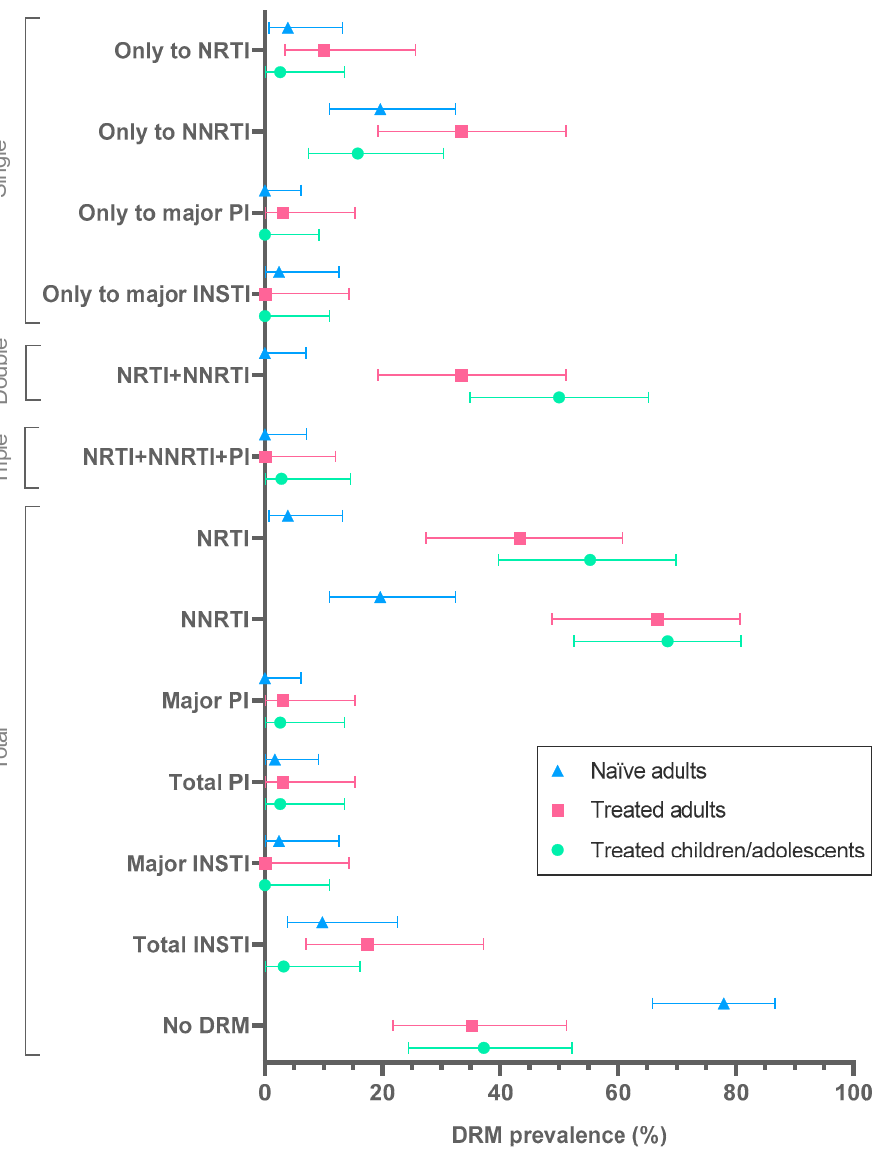
Figure 2. Percentage of HIV-infected patients carrying DRM to the main antiretroviral classes in Equatorial Guinea (2019–2020). Mean DRM prevalence (colored figures) and 95% confidence